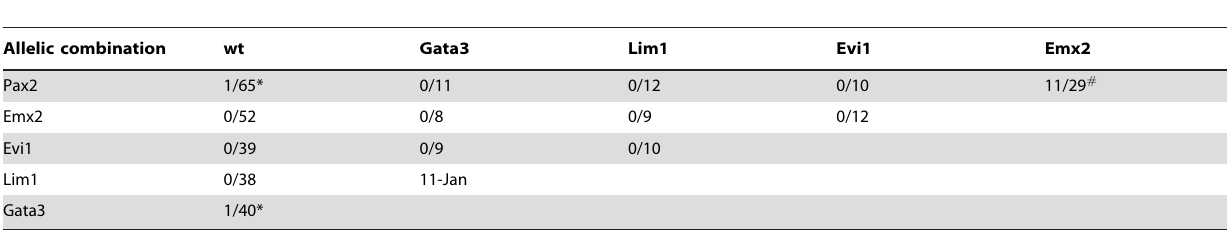
Numbers refer to embryos of the indicated allelic combination analyzed. *The single affected Pax2 + / 2 embryo displayed a unilateral duplex kidney with duplicated collecting duct system, the Gata3 + / 2 embryo displayed unilateral